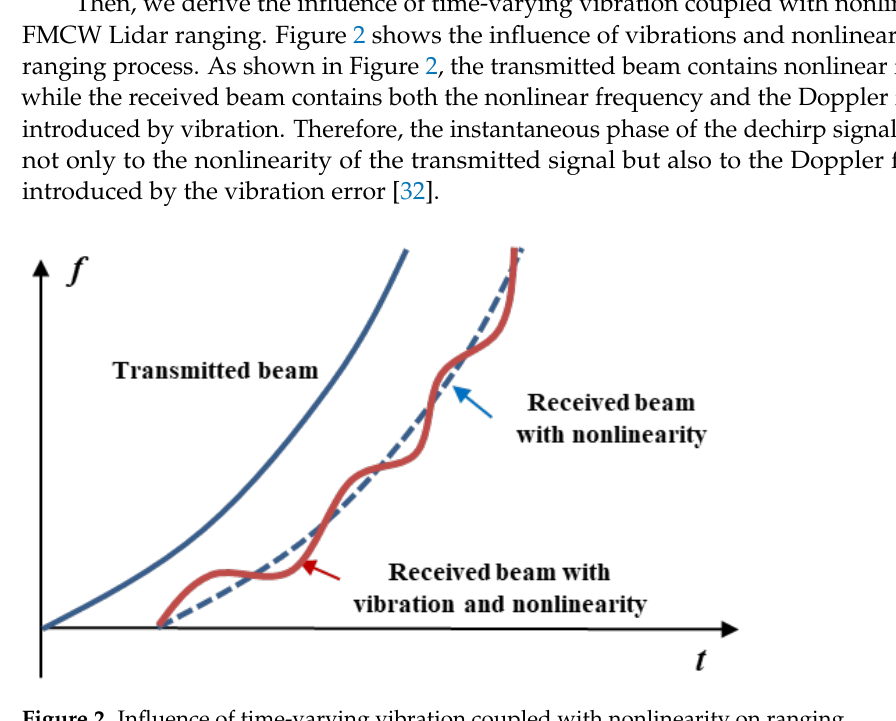
Figure 2. Influence of time-varying vibration coupled with nonlinearity on ranging. The ideal time delay τ equals to 2 R 0 / c . When the platform or the target has rel- ative vibration, the constant τ will be denoted as a time-varying time delay τ ( t ) that equals to 2 R ( t ) / c . R ( t ) is the instantaneous range of a target with vibration which can be expressed as